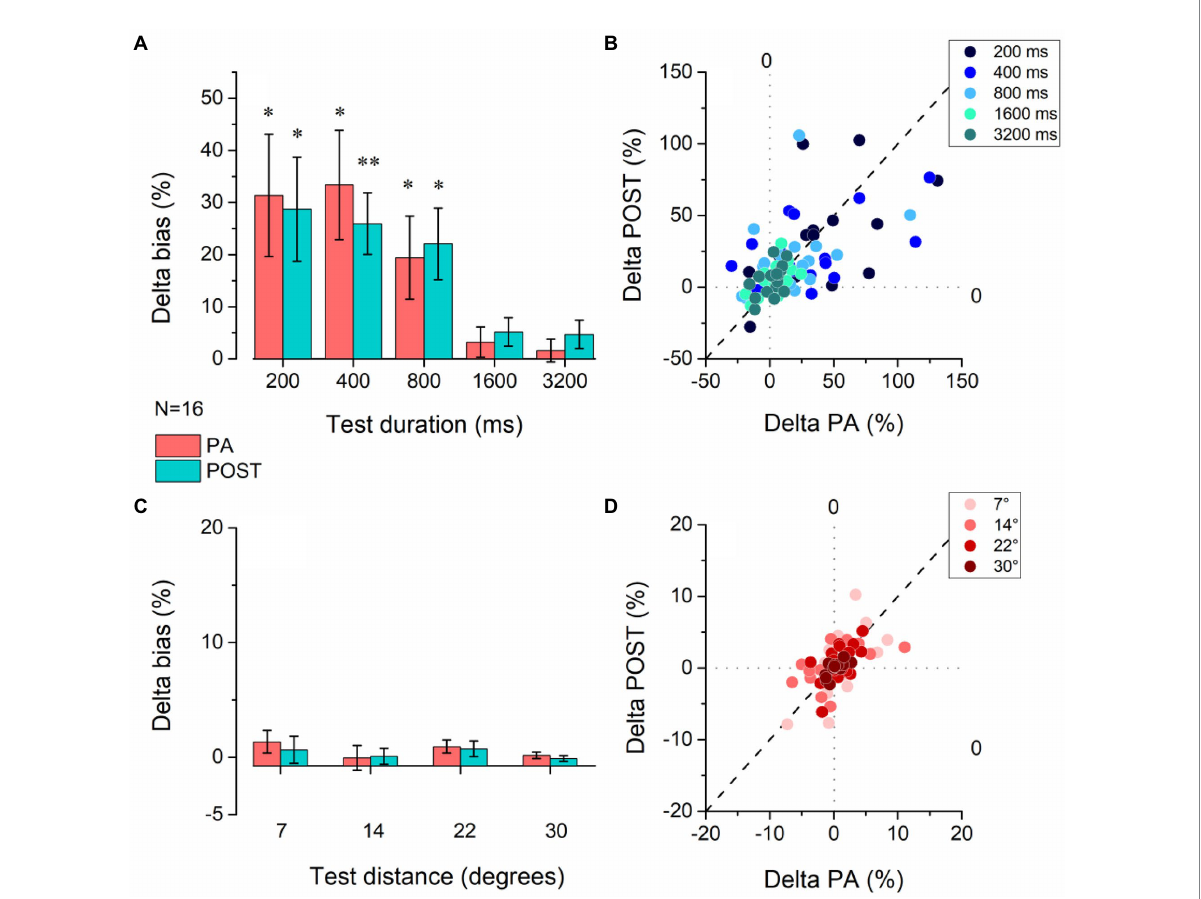
FIGURE 3 Effect of physical activity on temporal and spatial estimation. (A) Average delta values for the temporal task were obtained by subtracting the bias observed in the baseline session before physical activity from the experimental sessions measured during (PA – red bars) and after (POST –red) physical activity. The delta was calculated for each duration of the time estimation task. Error bars represent SEM. (B) Scatter plot of the delta values obtained for each participant during physical activity (delta PA) vs. after physical activity (delta POST) for all interval pedestals tested. (C) Average delta values for the spatial task were obtained by subtracting the bias observed in the baseline session before physical activity from the experimental sessions measured during (PA – red bars) and after (POST –red) physical activity. The delta was calculated for each duration of the time estimation task. Error bars represent SEM. (D) Scatter plot of the delta values obtained for each participant during physical activity (delta PA) vs. after physical activity (delta POST) for all distances tested. * p < 0.05, ** p < =0.01 (FDR correction for multiple comparisons applied to the p